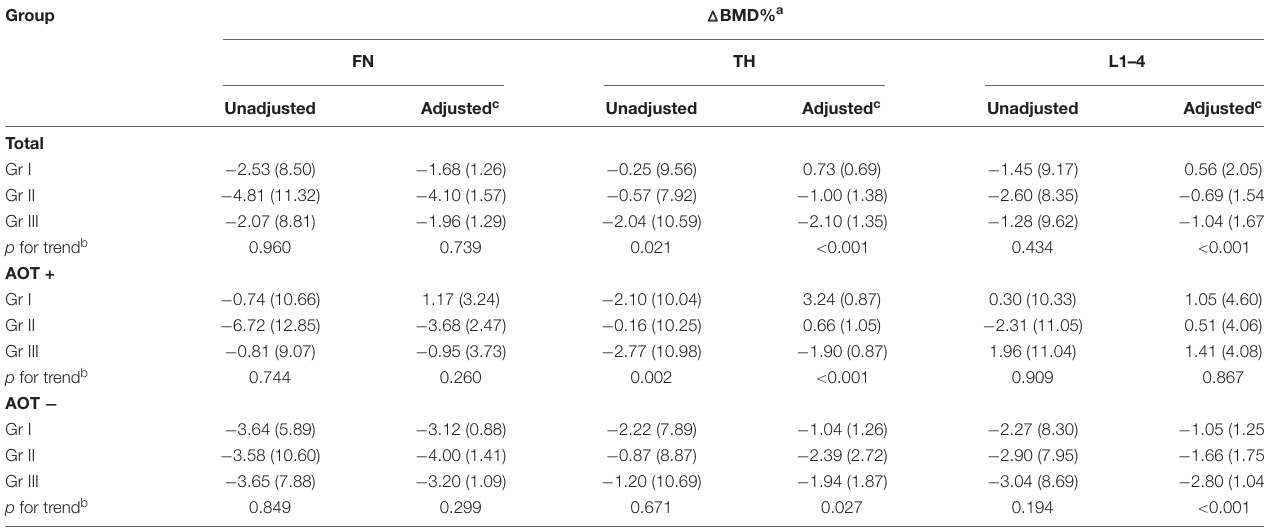
TABLE 4 | Regression-adjusted percentage change in BMD from baseline in each group, after matching. Group (cid:77)(cid:77)(cid:77) BMD% a FN TH L1–4 Unadjusted Adjusted c Unadjusted Adjusted c